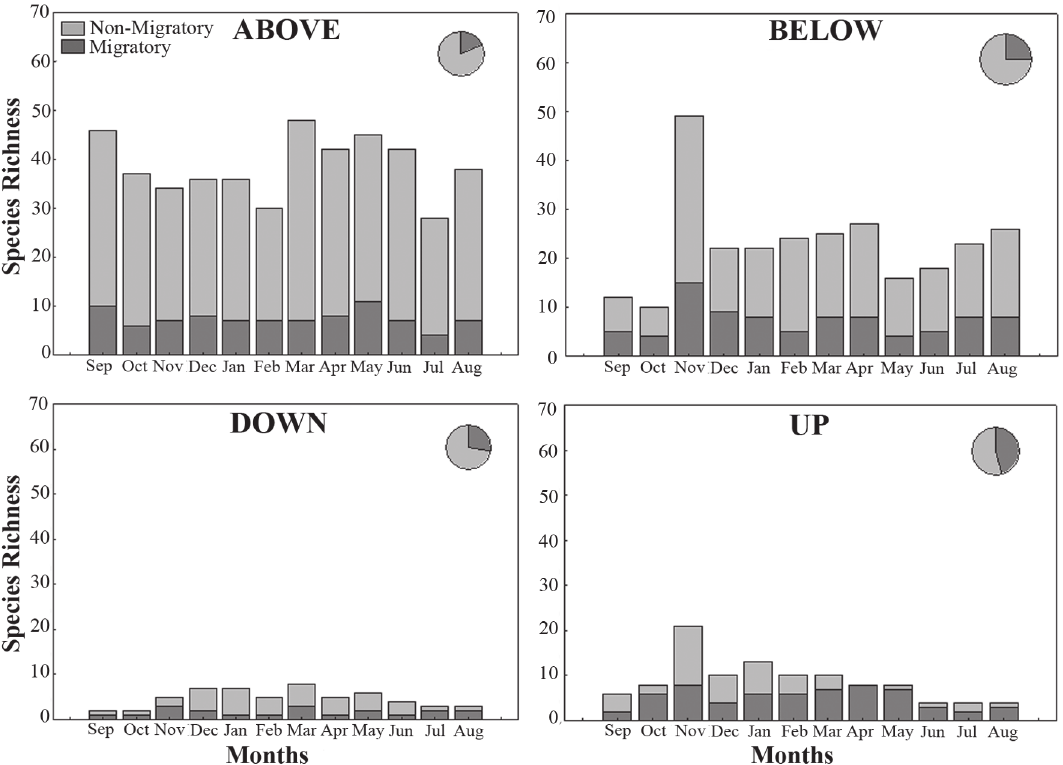
Fig. 2. Temporal trends in species richness of migratory and non-migratory fish captured around the dam (ABOVE and BELOW) and inside the ladder (DOWN and UP). Small charts indicate the contribution (%) of migratory and non-migratory species over the entire